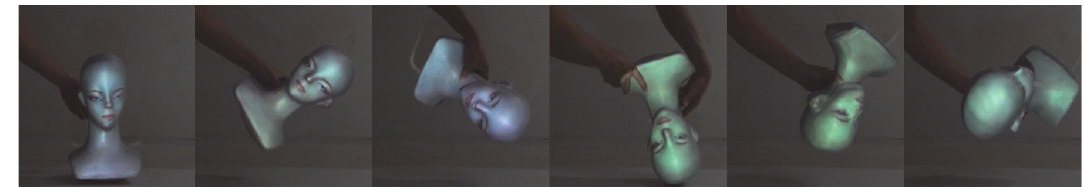
Figure 9: Results of dynamic SAR for a moving mannequin.